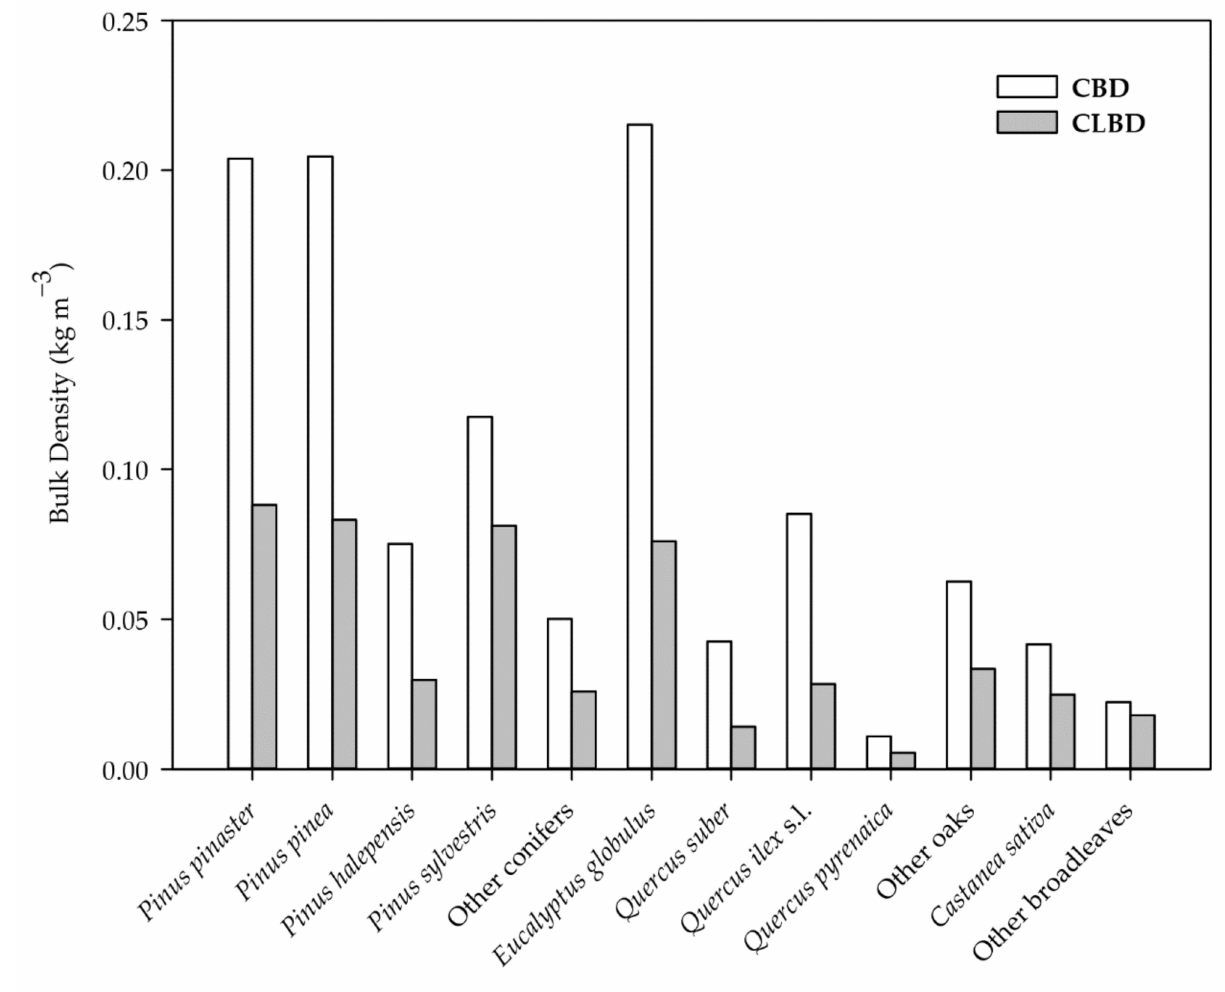
Figure 12. Mean values of tree Crown Bulk Density (CBD, in kg m − 3 ) and Canopy Layer Bulk Density (CLBD, in kg m − 3 ) for the tree species/groups in the Iberian